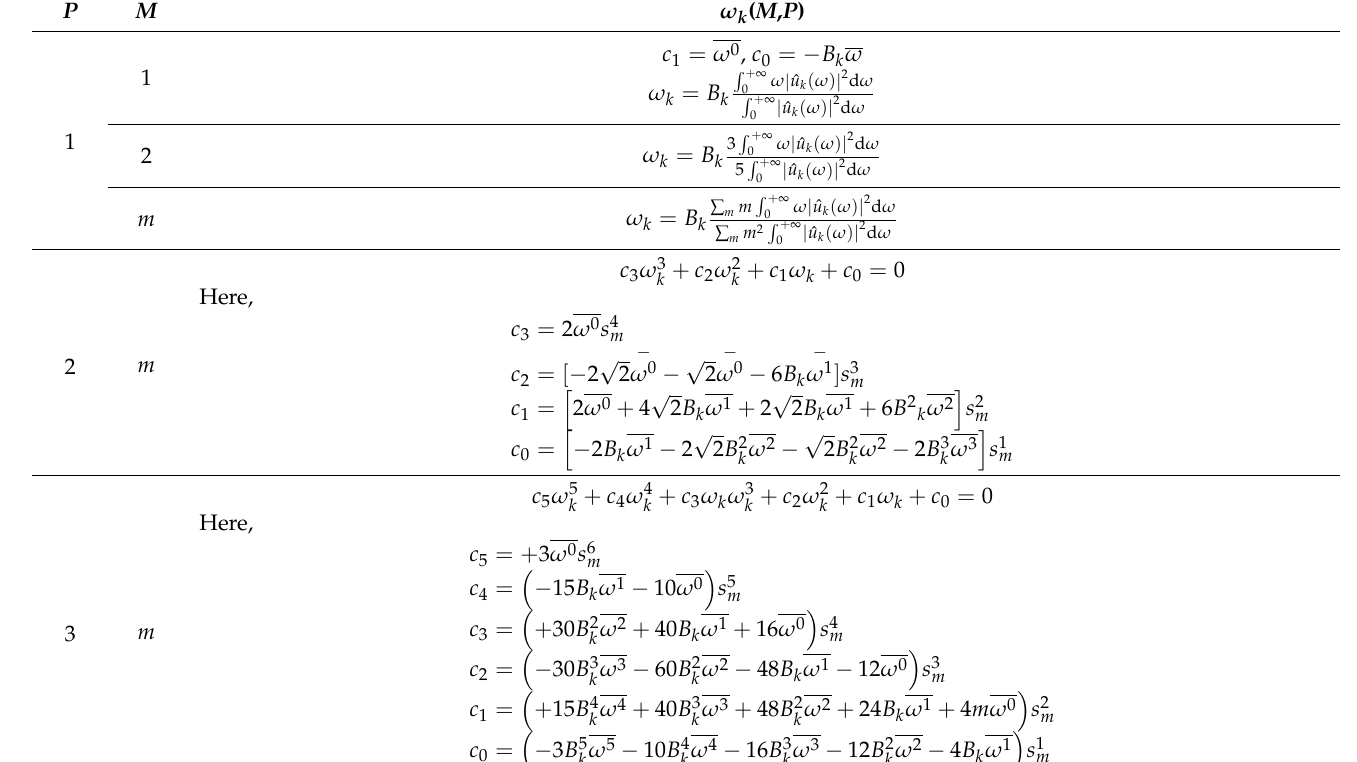
Table 2. The different solutions of ω k ( M , N )